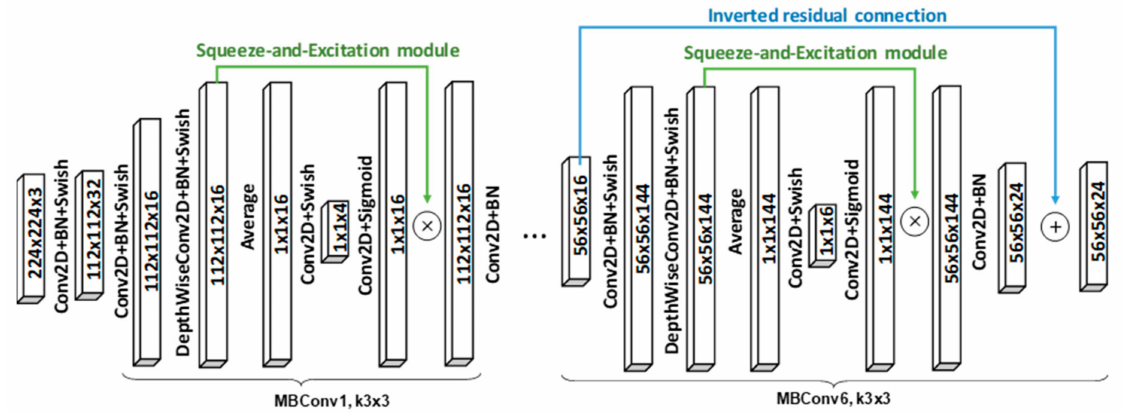
Figure 3. Illustration of the MBConv blocks in the EfficientNet CNN model. The figure shows two types of blocks: MBConv1 (always used at the start of the model) and MBConv6 (used within the